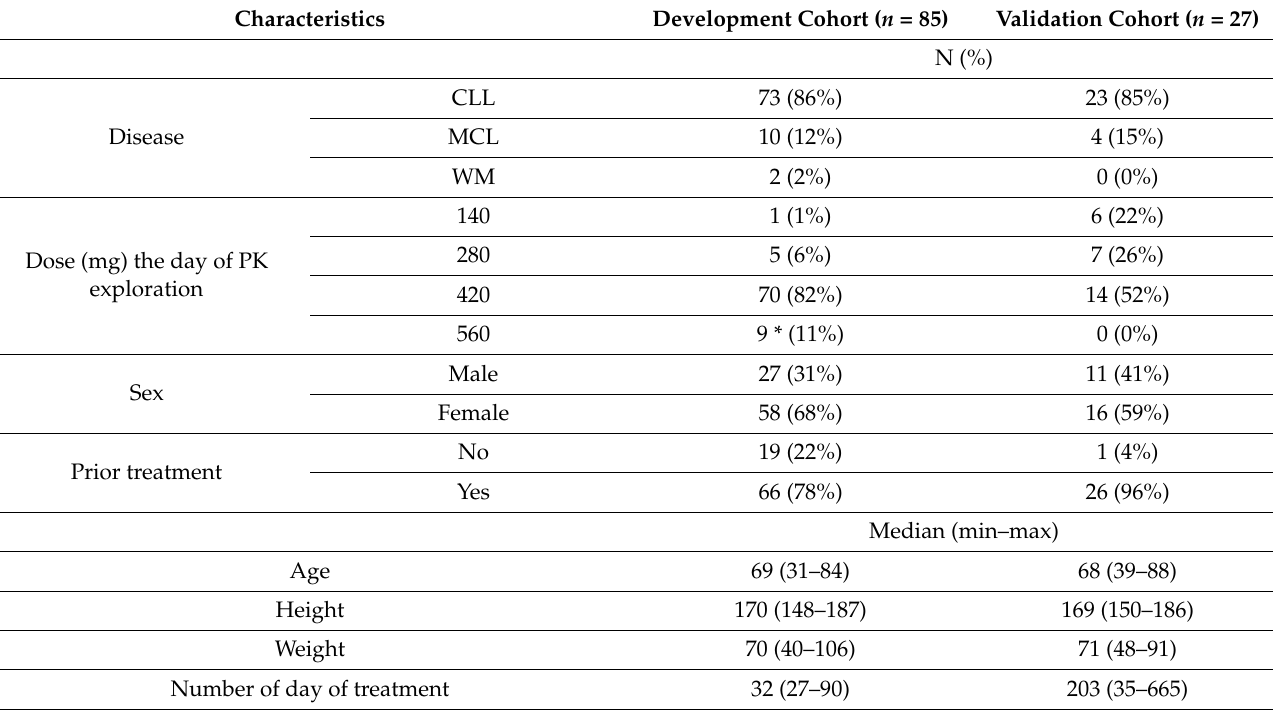
Table 1. Patients’ characteristics in the development and validation